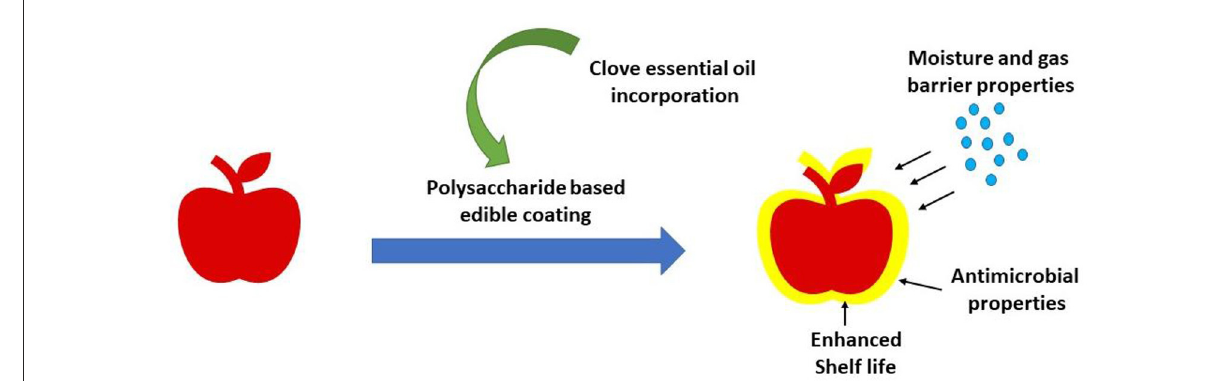
FIGURE13 Application of edible coating on fruit.